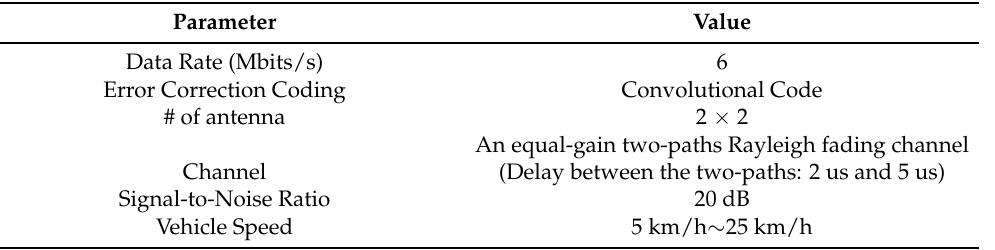
Table 3. Simulation